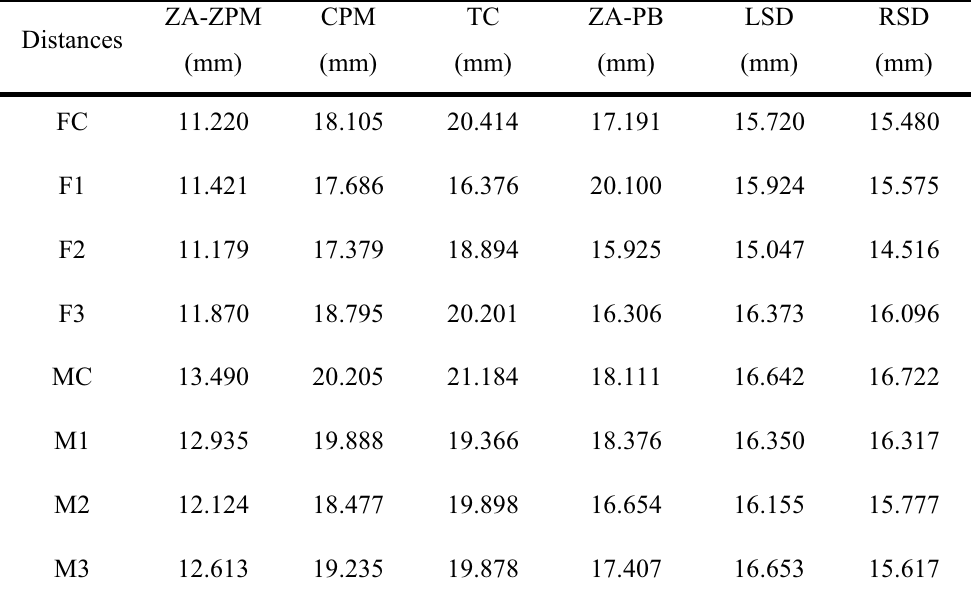
TABLE 2 - Each anatomic landmark measured with CAT scan